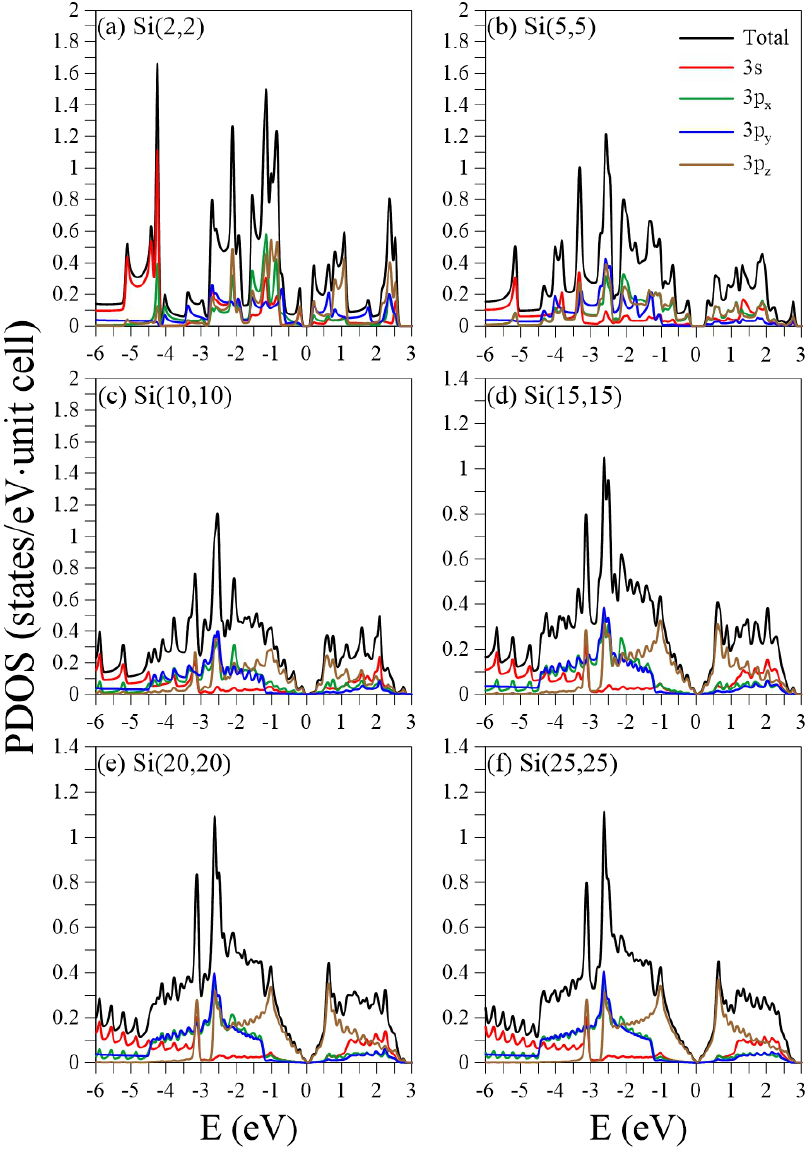
Figure 7. The orbital-projected densities of states for aSiNTs with different chiral vectors: ( a ) (2,2), ( b ) (5,5), ( c ) (10,10), ( d ) (15,15), ( e ) (20,20), and ( f )